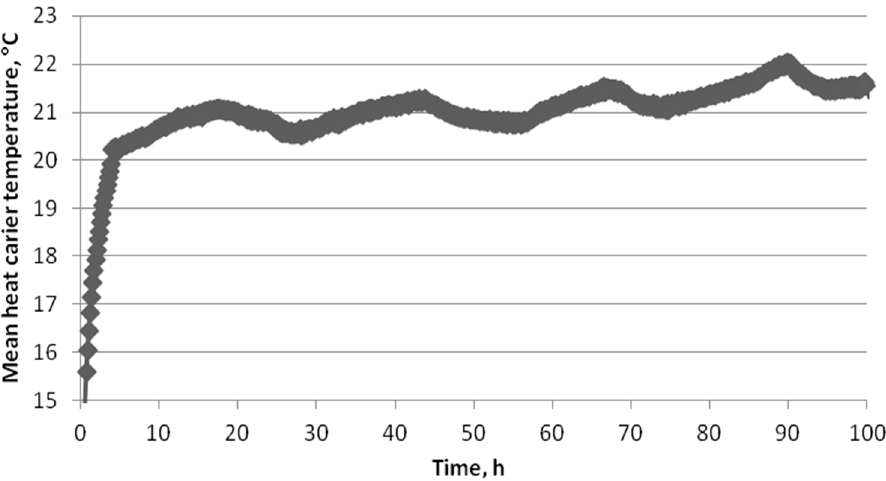
Figure 7. TRT results with the measurement data averaging every 1 h in a semi-logarithmic plot, together with the linear regression equation.